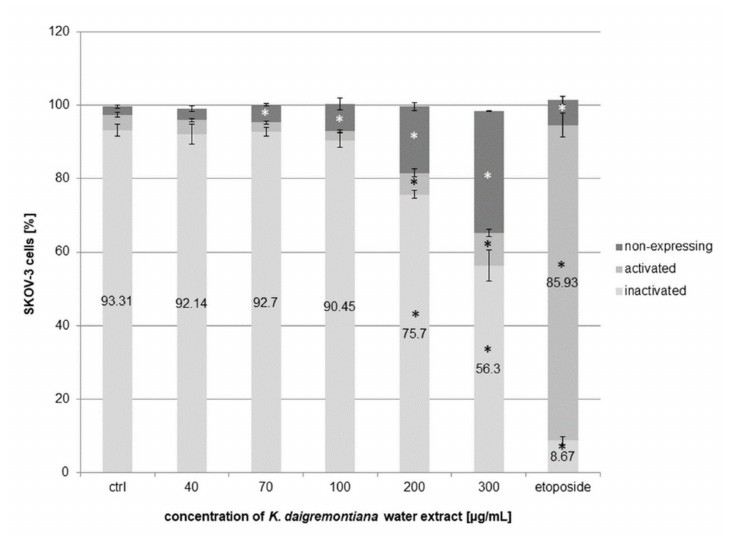
Figure 10. The effects of K. daigremontiana water extract on H2A.X activation in SKOV-3 cells. The cells were treated with the extract at concentrations of 40–300 µ g/mL and etoposide at a concentration of 10 µ M for 24 h. The H2A.X activation was analyzed via flow cytometry. The values represent the means ± SD of three independent experiments. Error bars indicate standard deviations. Significant differences relative to the control are marked with an asterisk “*” (Student’s t -test, p < 0.05). 2.9. Kalanchoe Daigremontiana Extract Induced Cell Cycle Arrest in S and G2/M phases